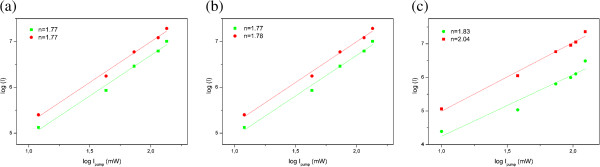
Power dependence of UC emissions. Dependence of the green (green line and symbols) and red (red line and symbols) UC emissions on excitation power for (a) Y1.97Yb0.02Er0.01O3, (b) Y1.94Yb0.05Er0.01O3, and (c) Y1.89Yb0.10Er0.01O3 NPs.